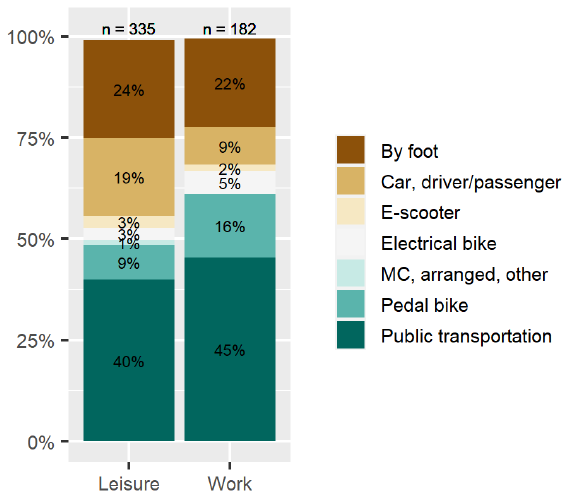
Figure 5. Transport mode distribution each for work and leisure